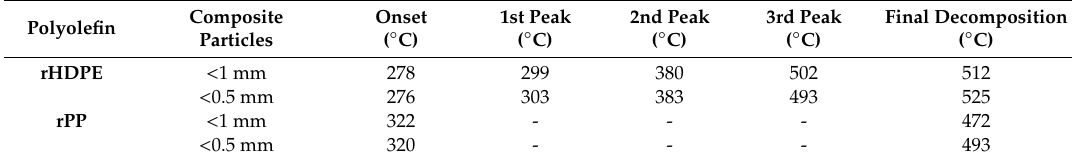
Figure 3. ( a ) Thermogravimetric analysis (TGA) and ( b ) differential thermogravimetric (DTG) curves for rice hull polyolefin composites. Table 3. Thermal degradation behavior of polyolefin composites.